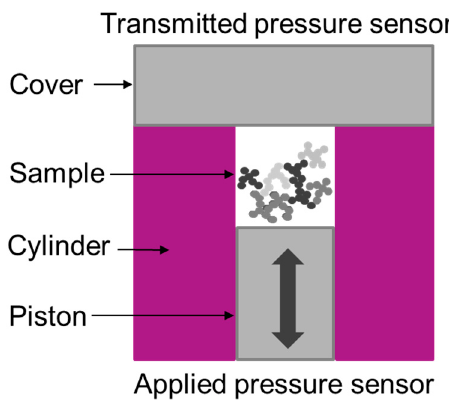
Figure 2. Schematic view of a void volume measurement system including a filler sample .